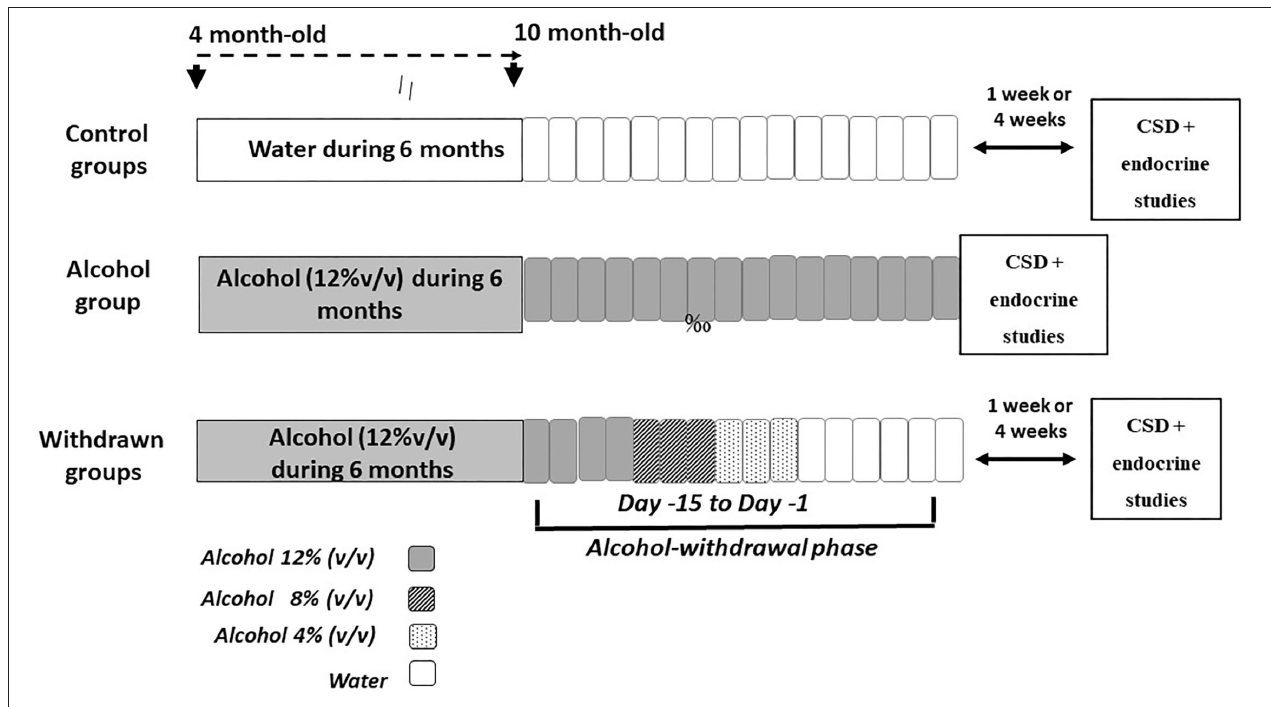
FIGURE 1 | Schematic overview of the alcohol exposure and withdrawal procedures. The withdrawn groups were submitted to a 6-month exposure to alcohol (120% v/v) followed by a withdrawal phase that lasted 15 days (from Day − 15 to Day − 1), during which alcohol was progressively withdrawn from the solution by steps of 4% (Day − 15 to Day − 12: alcohol 12%; Day − 11 to Day − 9: alcohol 8% v/v; Day − 8 to Day − 6: alcohol 4%; then water for the remaining days). Either 1- or 4-weeks after the end of the withdrawal phase, mice were submitted to memory testing in the CSD task followed by the endocrine study. The alcohol group was exposed to a 6-months alcohol exposure and was still under the alcohol solution at the time of memory testing. Control groups were exposed to the same general schedule except that they received permanently water as the sole source of